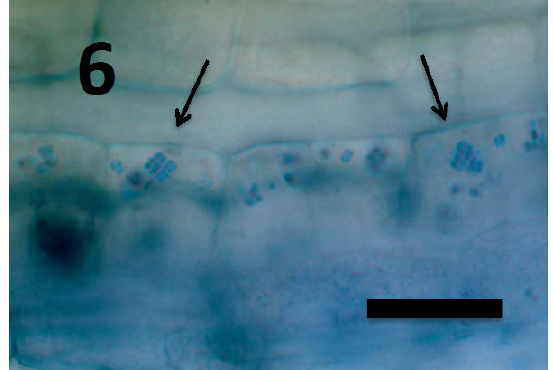
Figure 6. Rumex crispus seedling root parenchyma cells near root tip meristem showing internal presence of Micrococcus luteus tetrads (arrows; bar = 25 µm; stained with 3,3-diaminobenzidine followed by aniline blue).